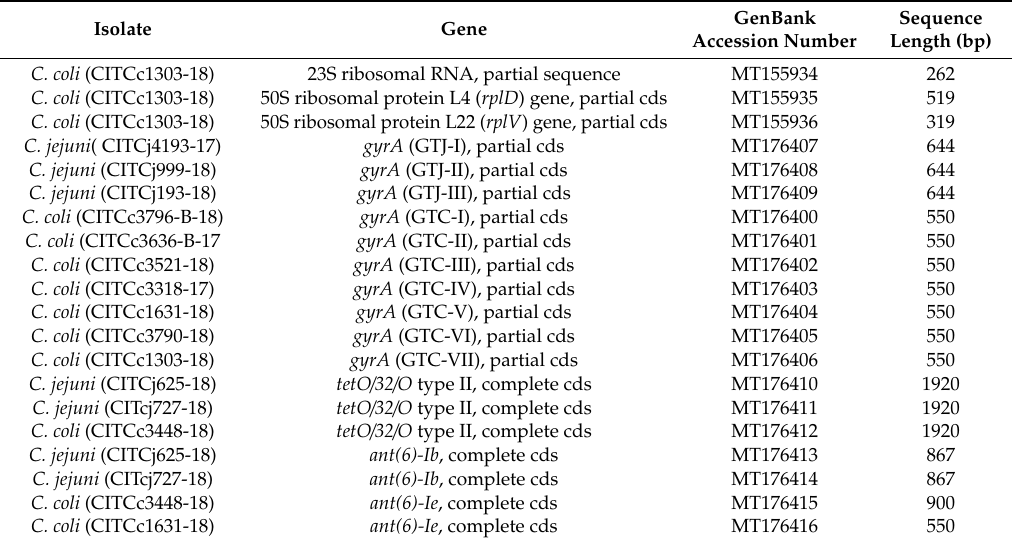
Table 5. Accession numbers of partial sequences submitted to GenBank in this